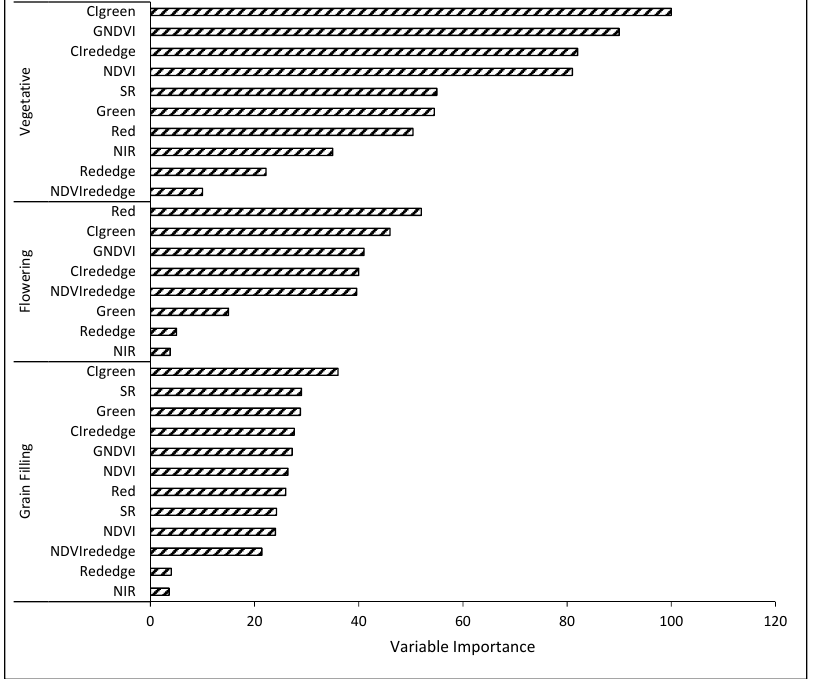
Figure 8. Variable importance at different phenological stages used in the classification process without optimization. NDVI = Normalized Difference Vegetation Index; GNDVI = Green Normalized Difference Vegetation Index; NDVIrededge = Rededge Normalized Difference Vegetation Index; SR = Simple Ratio, CIgreen = Green Chlorophyll Index; CIrededge = Rededge Chlorophyll Index.